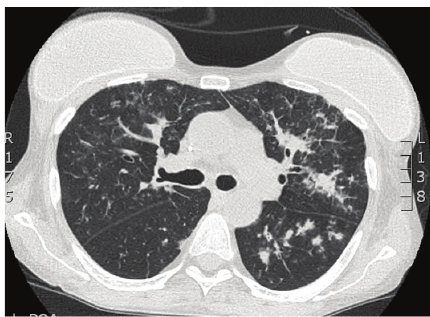
Figure 1: Chest CT scan showing confluent nodules and ground- glass patchy consolidations especially in the left